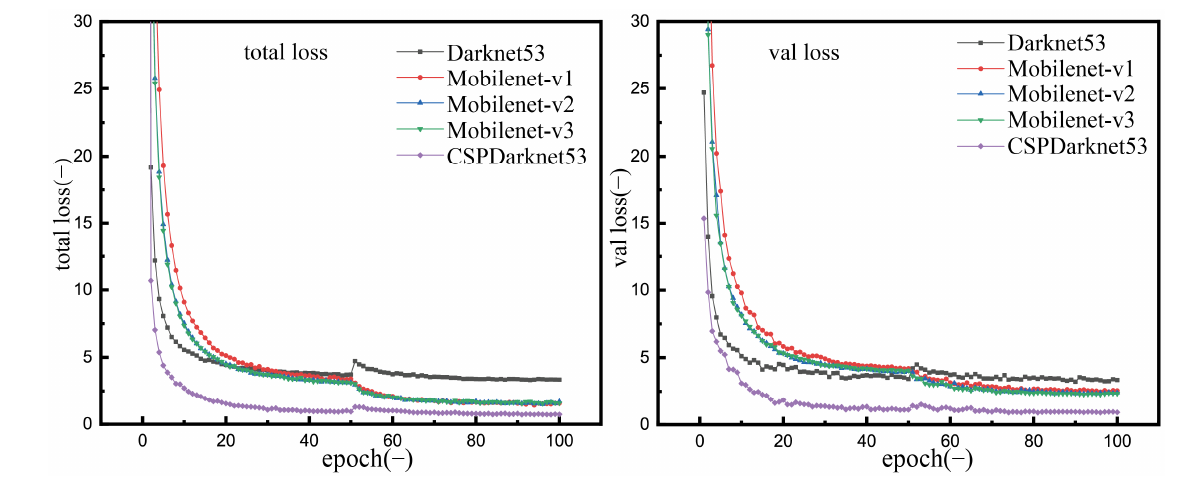
Figure 15. The loss curve of the five networks. Table 7. Comparison of the calculation consumption of the five network